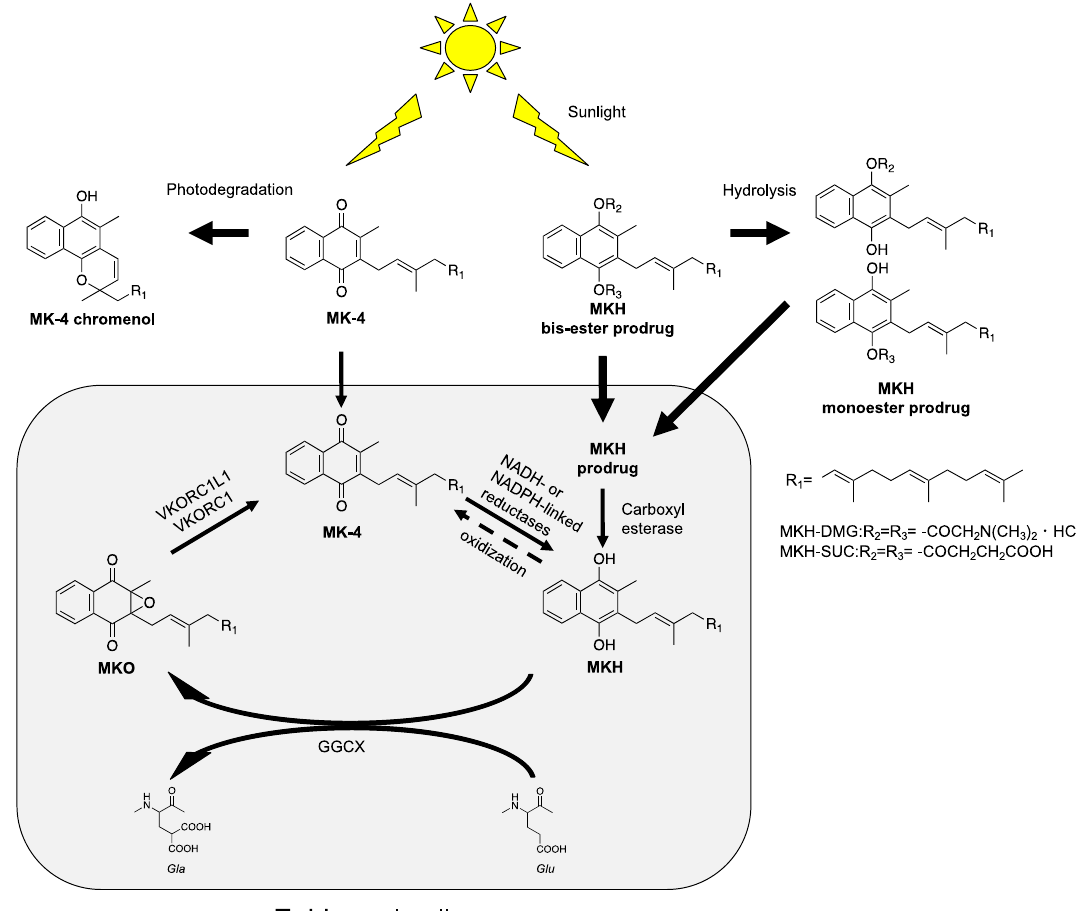
Figure 1. Concept of dermal delivery of MKH that avoids photoinstability and phototoxicity using a prodrug approach. Solid line: the advocated or expected processes based on the literatures and obtained results in this study. Dashed line: the possible process during the drug measurement.